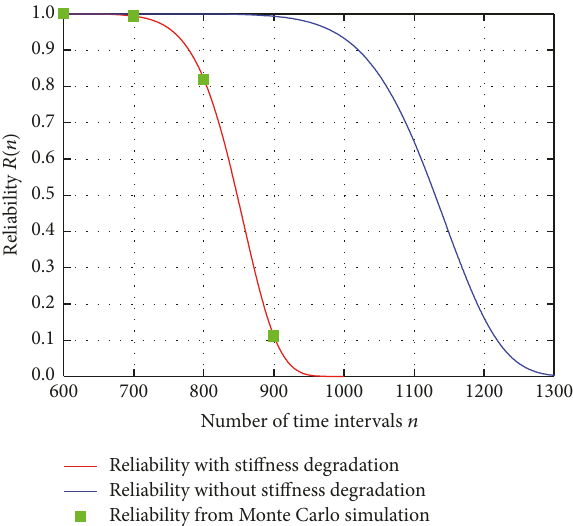
Figure 6: Lifetime PDF of belt drive systems.